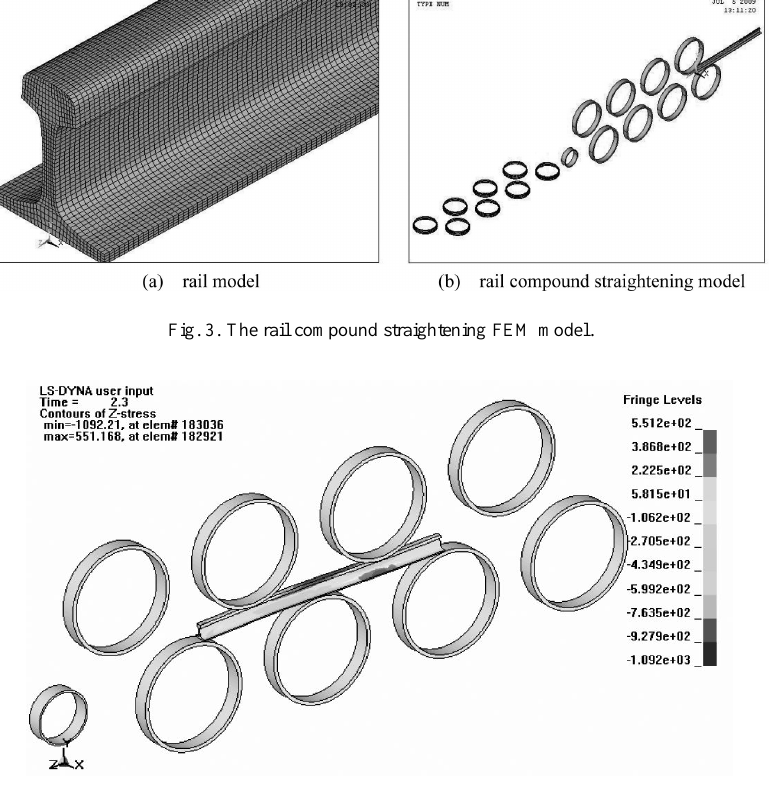
Fig. 4. Longitudinal stress during H-straightening.